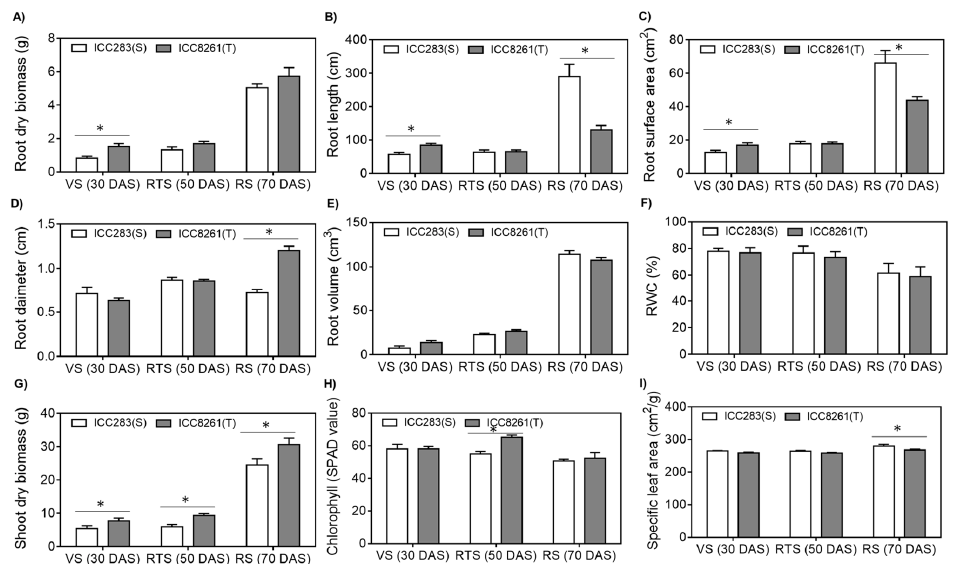
Figure 1. Growth and physiological responses of tolerant (T, ICC8261) and sensitive (S,